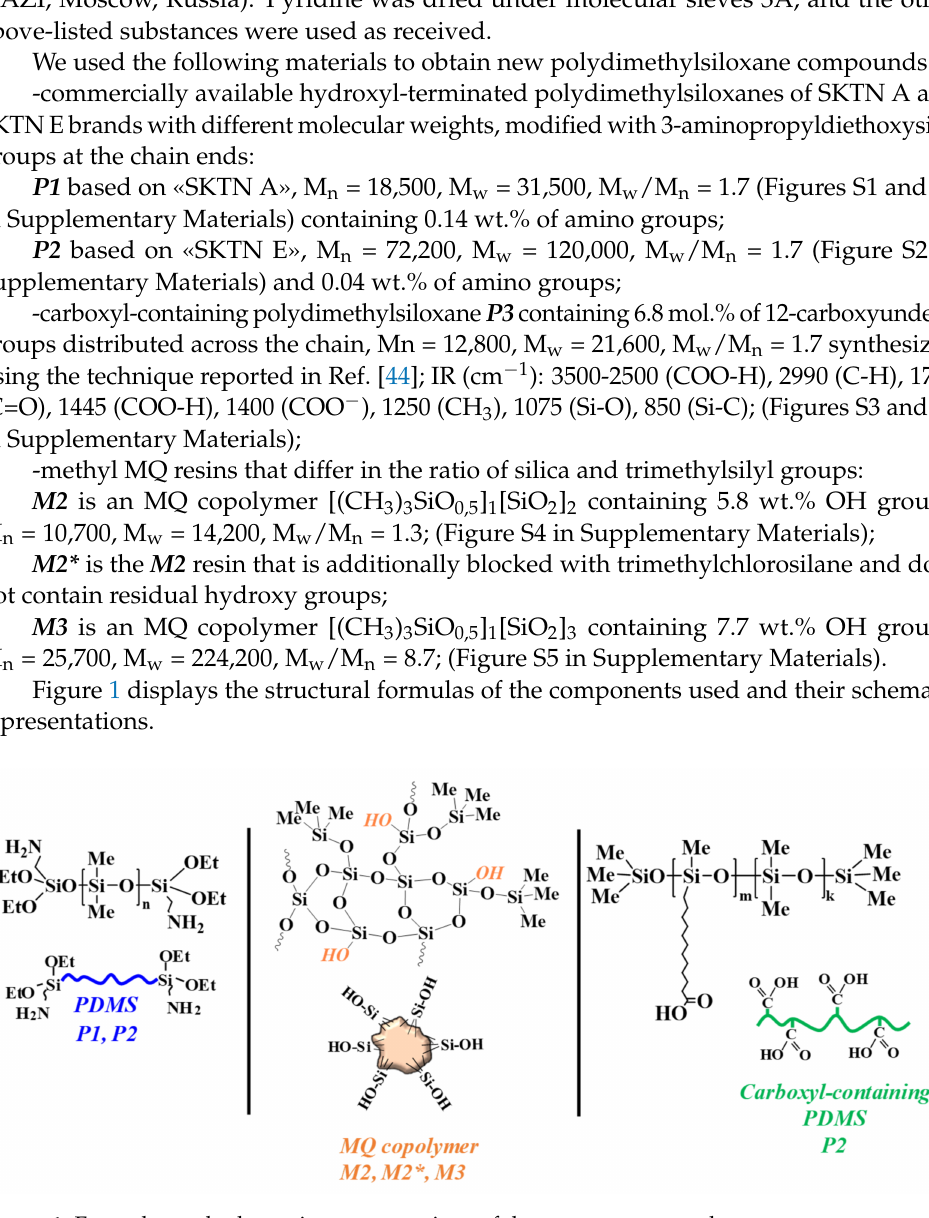
Figure 1. Formulas and schematic representations of the components